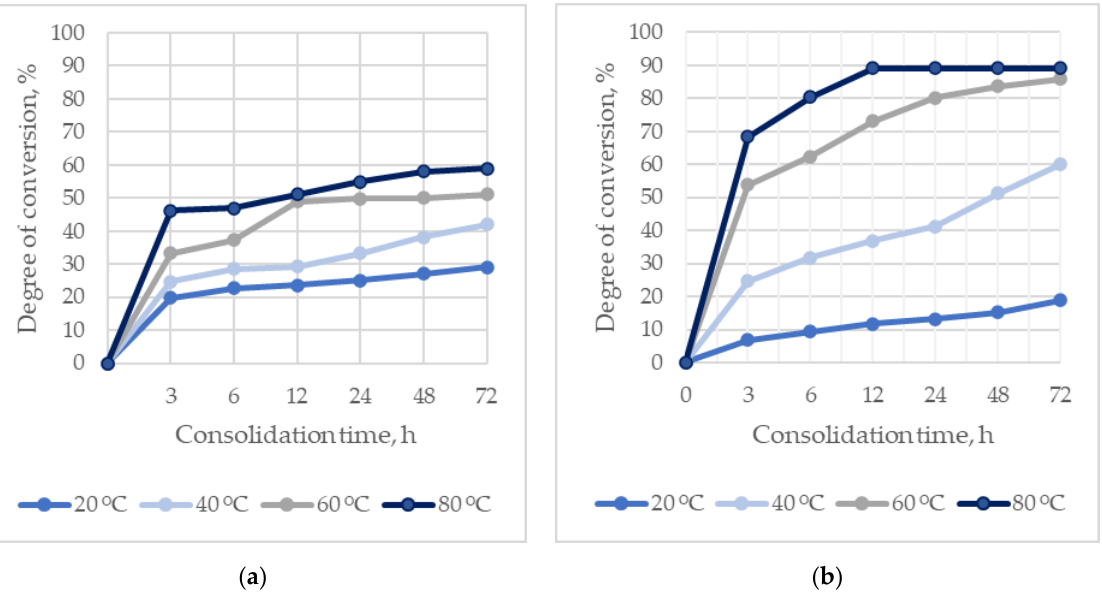
Figure 3. Kinetic curves of hydroxyapatite formation during consolidation of ceramics based on α -TCP with the following particle sizes: ( a ) D [3,4] 37.02 μm (α -TCP1); ( b ) D [3,4] 6.12 μm (α -TCP2).